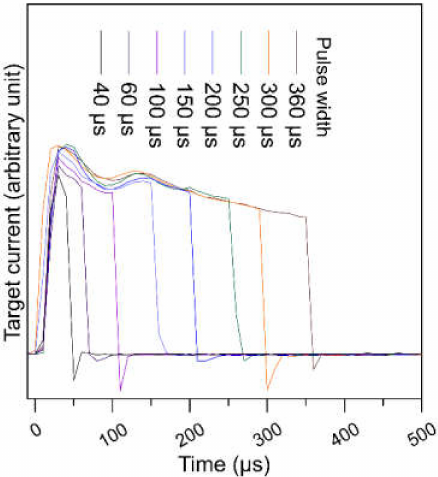
Figure 1. The single current pulse shapes at square pulse voltage but di ff erent pulse width for discharges with a Cr target in argon at 0.8